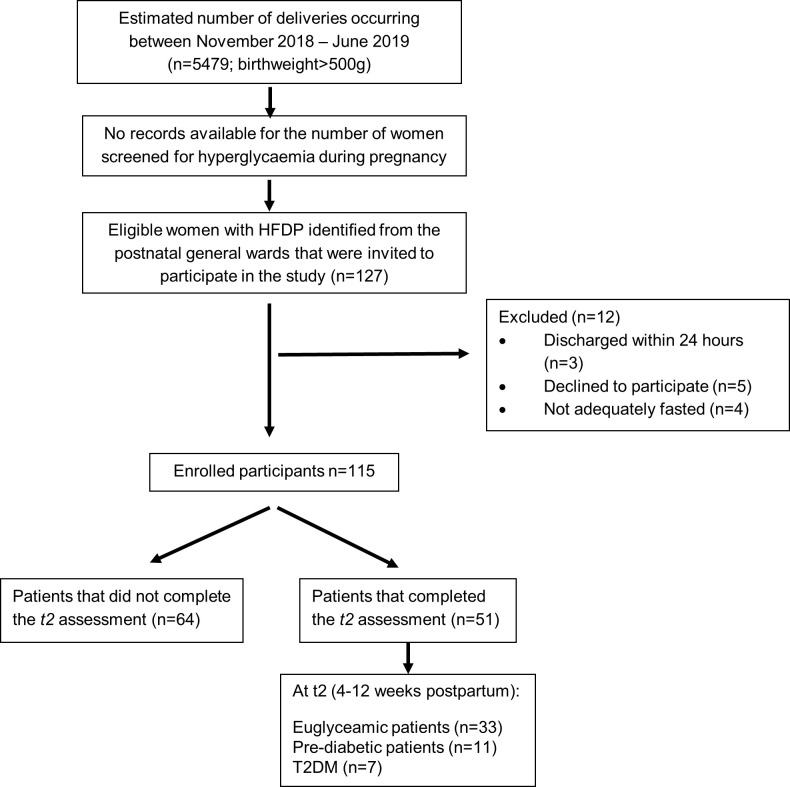
Overview of the study design.The diagram illustrates the number of eligible women that were recruited from the general postnatal ward after delivery as well as the number of enrolled patients.